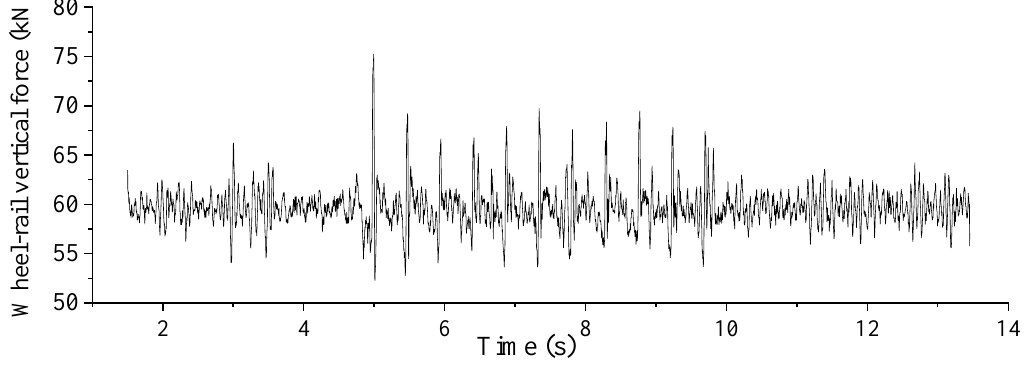
Figure 16. Time history curve of wheel–rail vertical force.